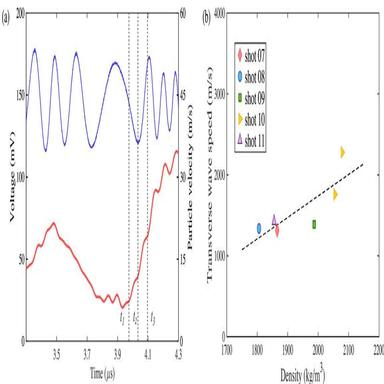
Average transverse wave speed of granular material: (a) TDI trace (blue) and corresponding processed transverse particle velocity (red); time of wave arrivals are indicated on the graph. (b) the evolution of granular shear wave speed with respect to density. (For interpretation of the references to color in this figure legend, the reader is referred to the web version of this article.)